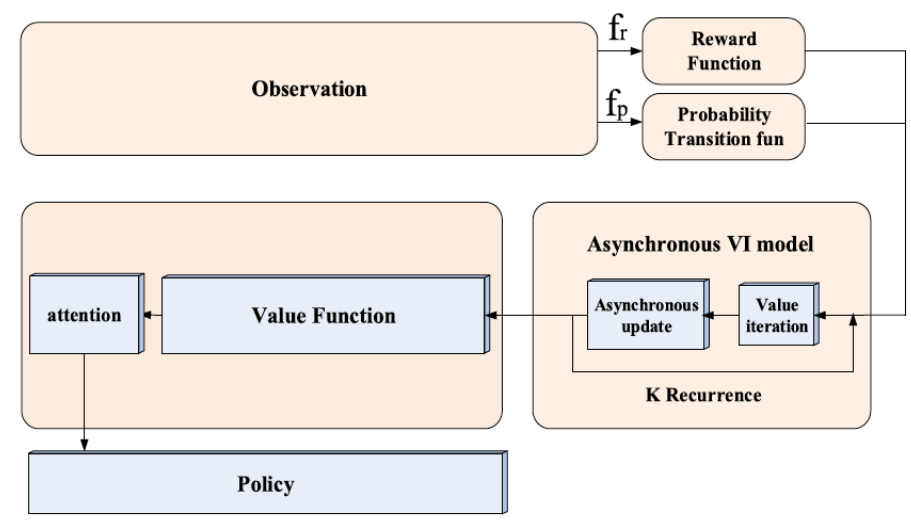
Figure 3. Illustration of the VIN structure utilized in the learning process.